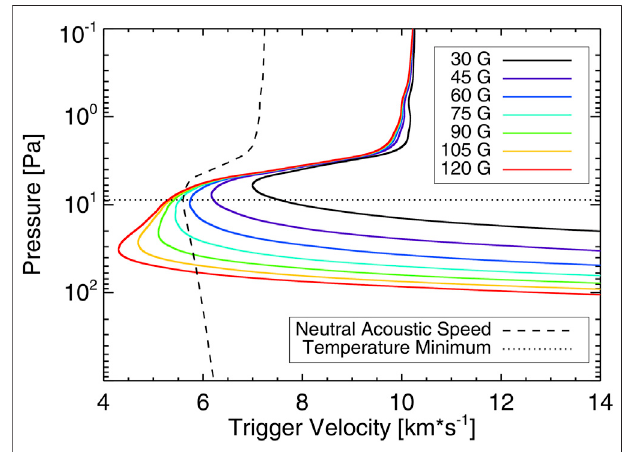
FIGURE 11 | FBi trigger velocity in the solar chromosphere for several magnetic fi eld strengths. The plot is limited to pressures near the temperature minimum. The trigger velocity decreases near the temperature minimum, reaching speeds as low as 4 km s − 1 . The neutral acoustic speed is plotted with a dashed line for reference. Adapted from Madsen et al. (2014). © AAS. Reproduced with